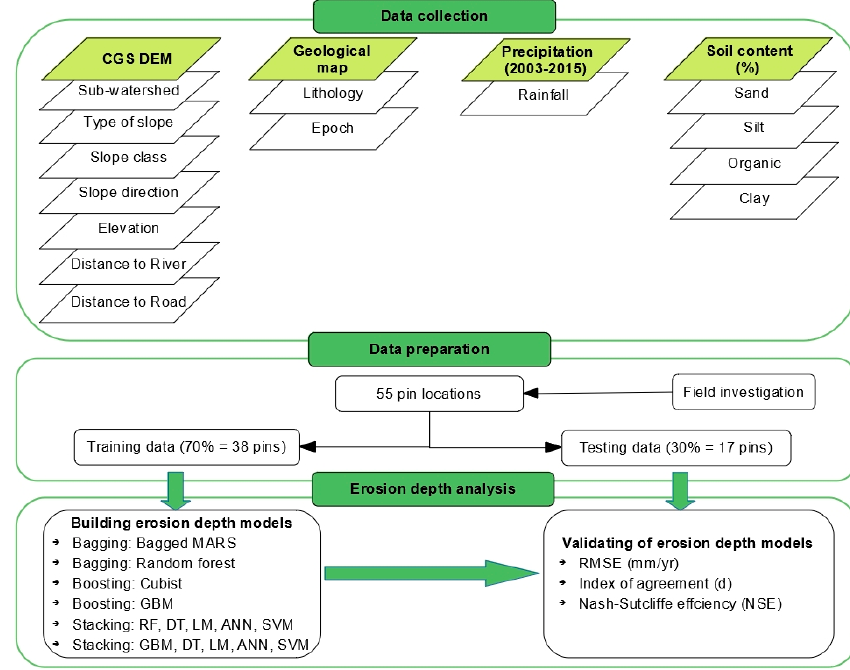
Figure 3. The soil erosion pin modeling flow chart using ensemble methods. Table 1. The predictive factors used in the modeling of soil erosion pin of the study area.